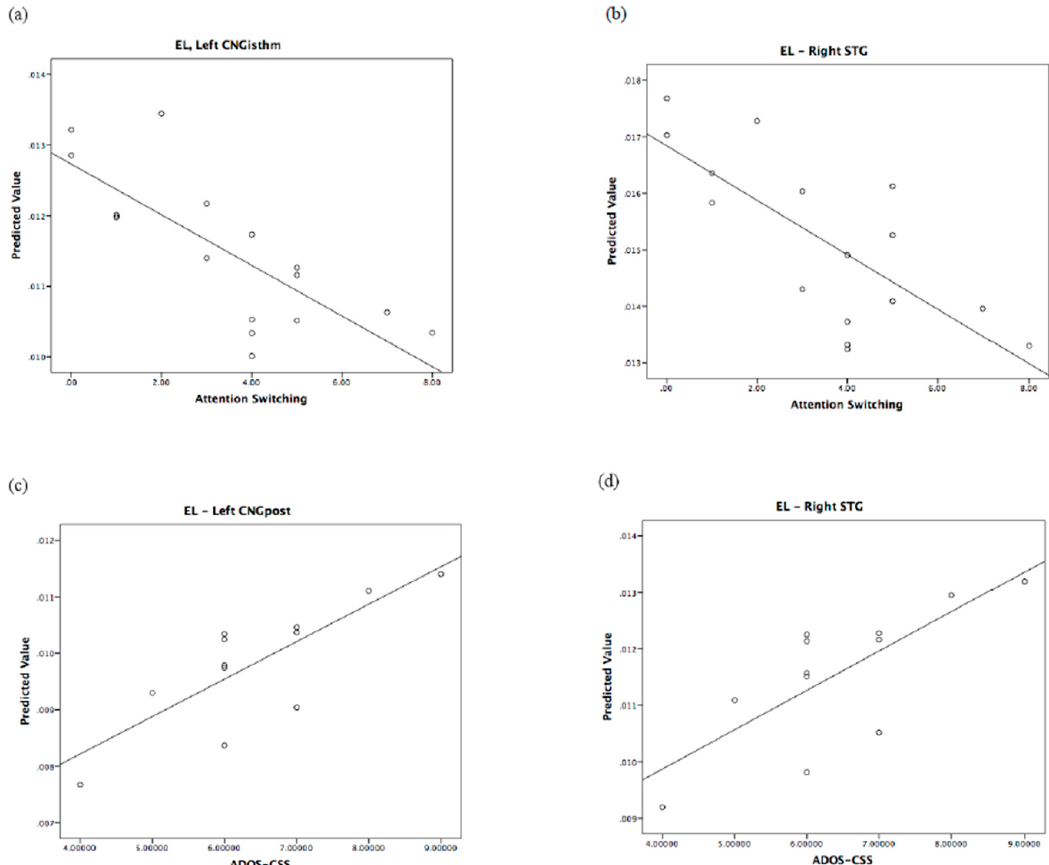
Figure 3. Regional local efficiency correlates of autistic traits in fathers and of autism severity in children. Top: predicted values vs. AQ domains in fathers. Bottom: predicted values vs. ADOS in children. EL: local efficiency.